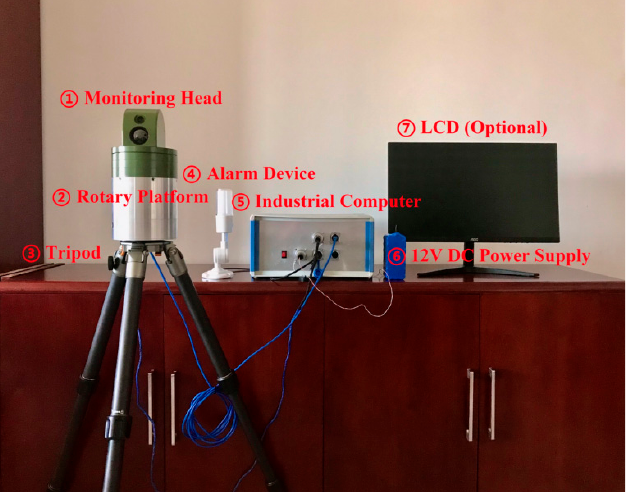
Figure 1. Hardware composition of the novel system. In practical use, the LCD is unnecessary.